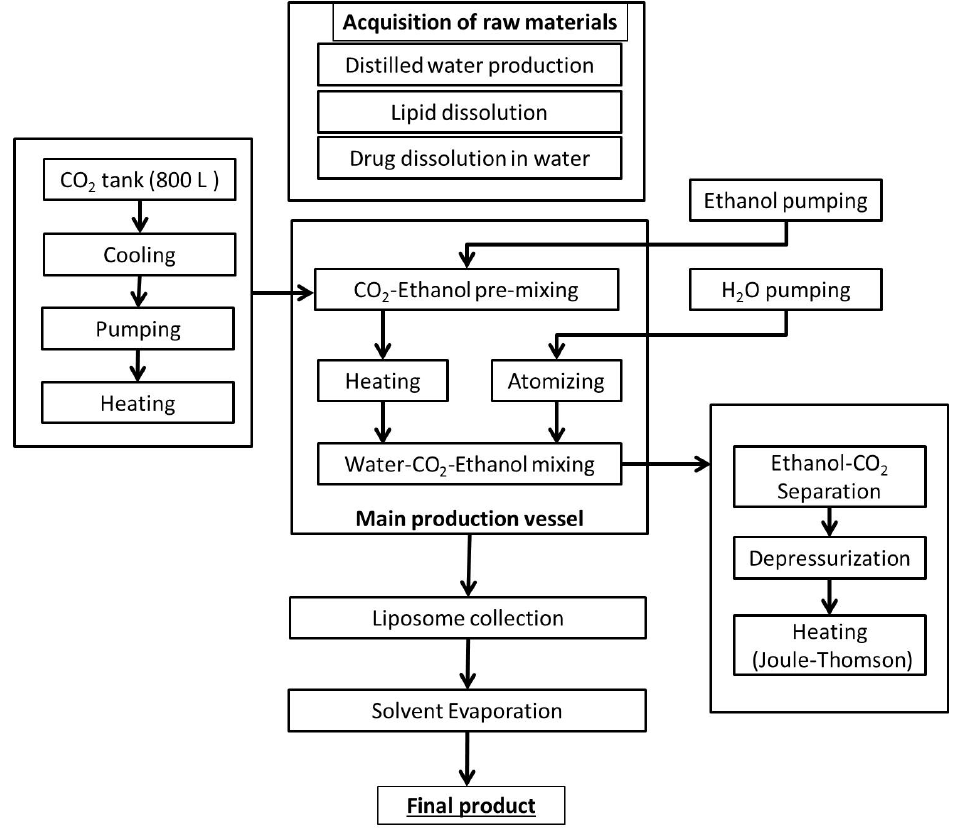
Figure 3. SuperLip system boundaries.